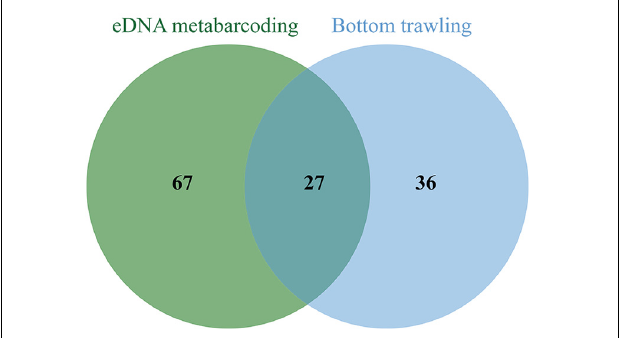
FIGURE 4 | Number of fish species identified by eDNA metabarcoding and bottom trawling in both summer and winter in the Zhoushan Sea (China).